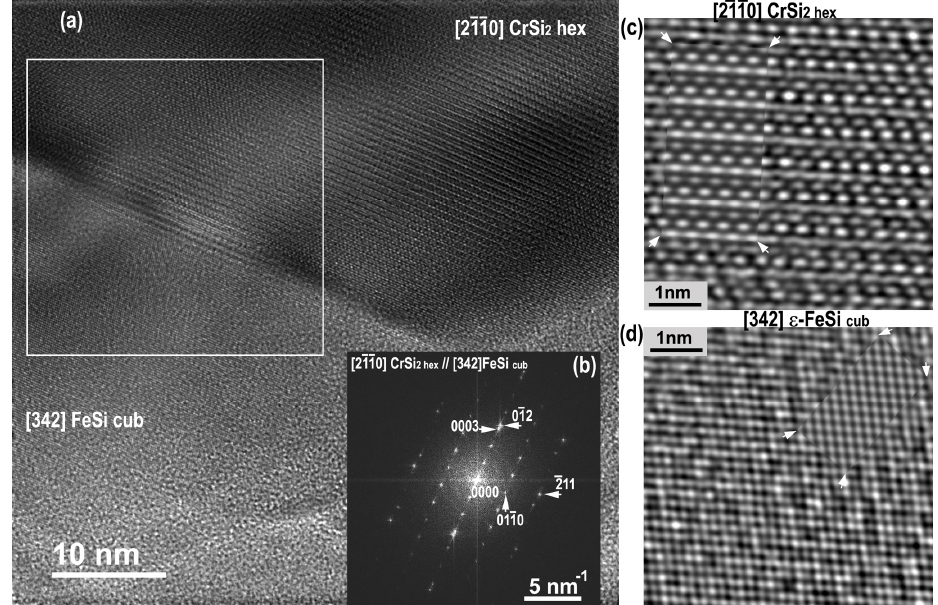
Figure 10. Annealed sample: HRTEM image taken at the interface FeSi cub / CrSi 2 hex ( a ), Fourier diffractogram obtained from the selected rectangular area brings their zone axis [2110] and [342], respectively ( b ); filtered HRTEM images from the [2110] CrSi 2 hex and [342] FeSi cub. HRTEM insets delimited by arrows are simulated HRTEM images using JEMS ( c , d